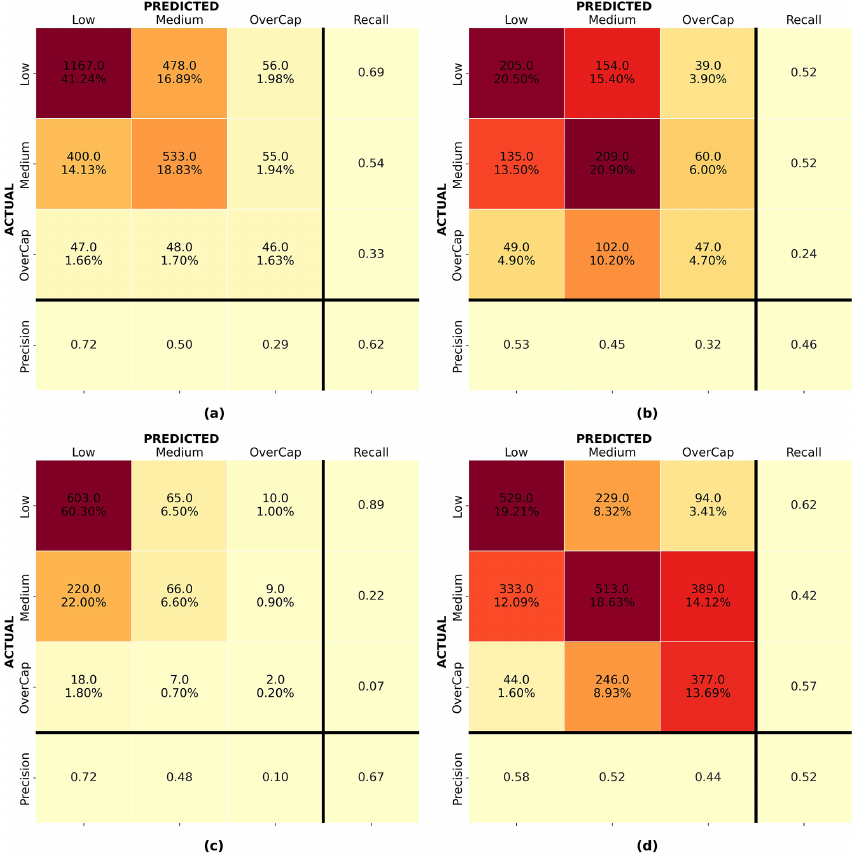
Figure 12. Confusion matrices for the random forest algorithm: (a) 4 September 2010 model validated on 4 September 2010, (b) 4 September 2010 model applied to 22 February 2011, (c) 22 February 2011 model applied to 4 September 2010, and (d) 22 February 2011 model validated on 22 February